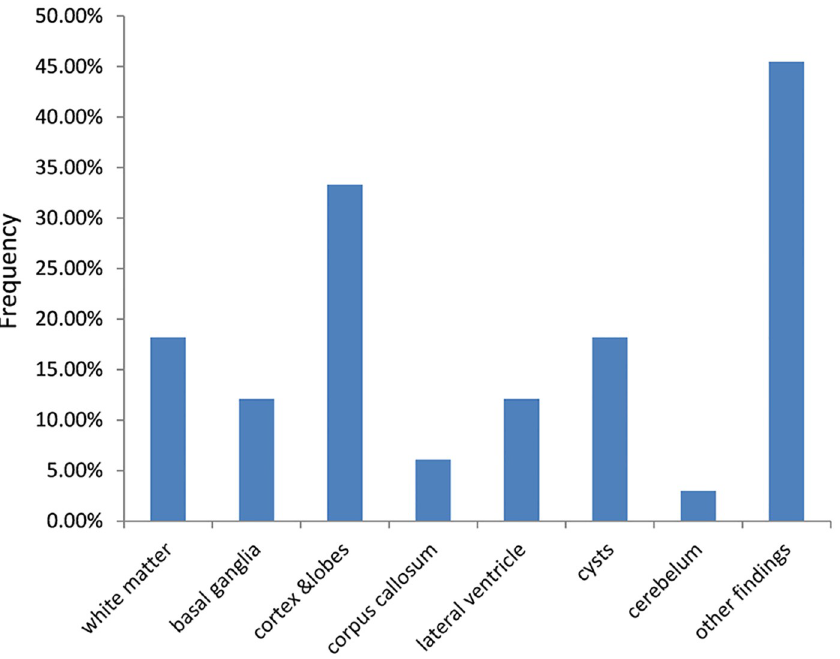
Fig 2. Distribution of neuroimaging pathology among pediatric patients with cerebral palsy from January 2016 to August 2019. Neuroimaging anomalies included pathologies of the white matter (18.2%), basal ganglia (15.2%), cortex and lobes (27.3%), corpus callosum (6.1%), lateral ventricle (12.1%), cysts (18.2%) and cerebellum (3%), respectively. Other findings were found in 45.5% of the patients.